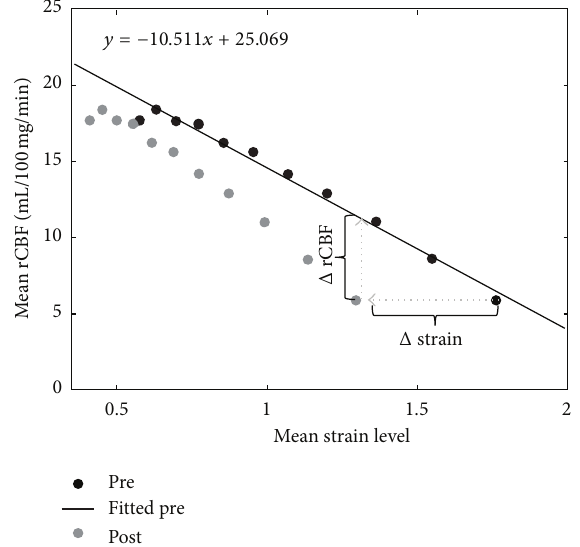
Figure 6: A linear relationship ( 𝑟 = 0.9905 , 𝑃 < 0.0001 ) was found to exist between the preoperative strain levels ( x -axis where 1 = 100 % strain level increase) and the regional cerebral blood flow (rCBF) (black dots, data from a previous publication [1]. One point was illustrated to show improved rCBF due to shunt operation (light dots, Δ